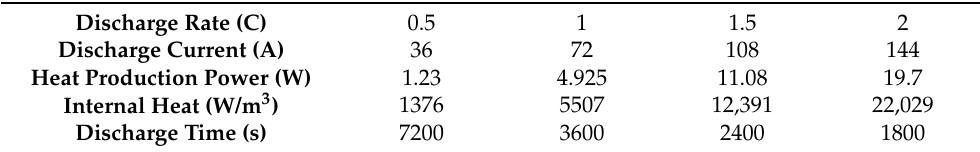
Table 3. Battery discharge